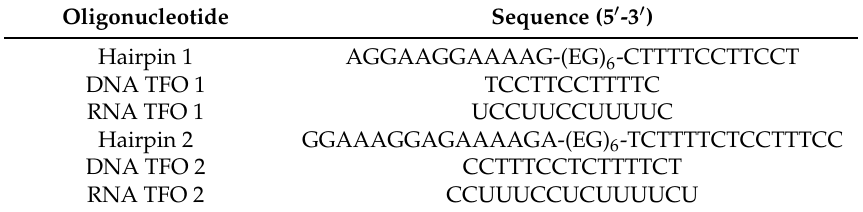
Table 1. Sequences of oligonucleotides used in this study. (EG) 6 indicates the hexaethyleneglycol linker.